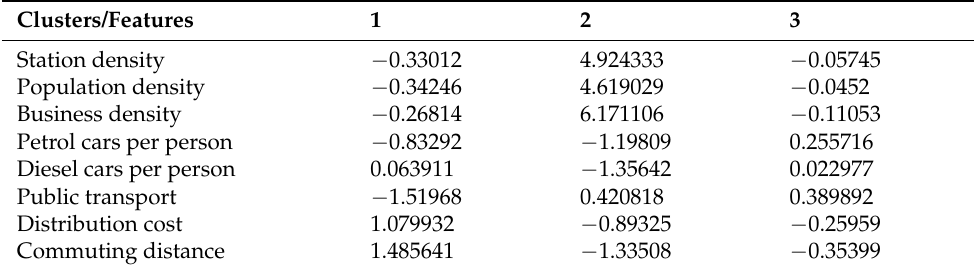
Table 3. Descriptive statistics of attributes at the cluster